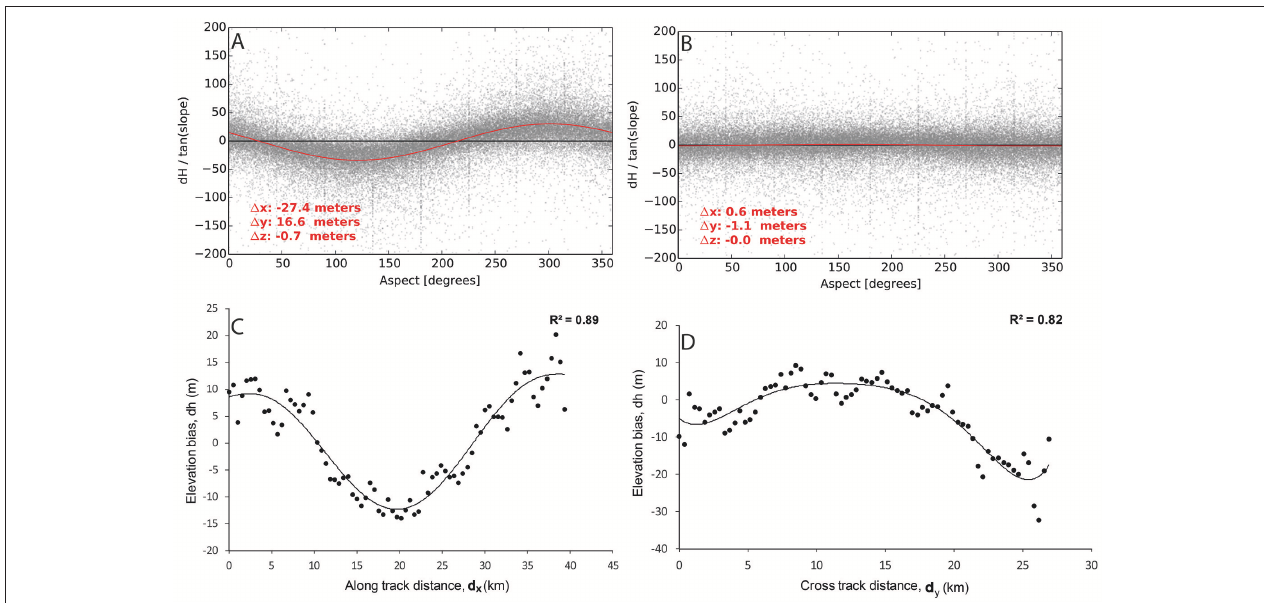
FIGURE 2 | Plots of slope normalized terrain elevation differences between the 2013 SETSM DEM and the 2000 SRTM DEM over stable (non-glacier) terrain before co-registration (A) and after four iterations of co-registration (B) . The co-registration shifts that were applied are shown in red text. (C) Shows the sixth-order polynomial fitted to the along-track elevation bias on the 1970 Corona DEM. (D) Shows the sixth-order polynomial fitted to the cross-track elevation bias on the 1970 Corona DEM.